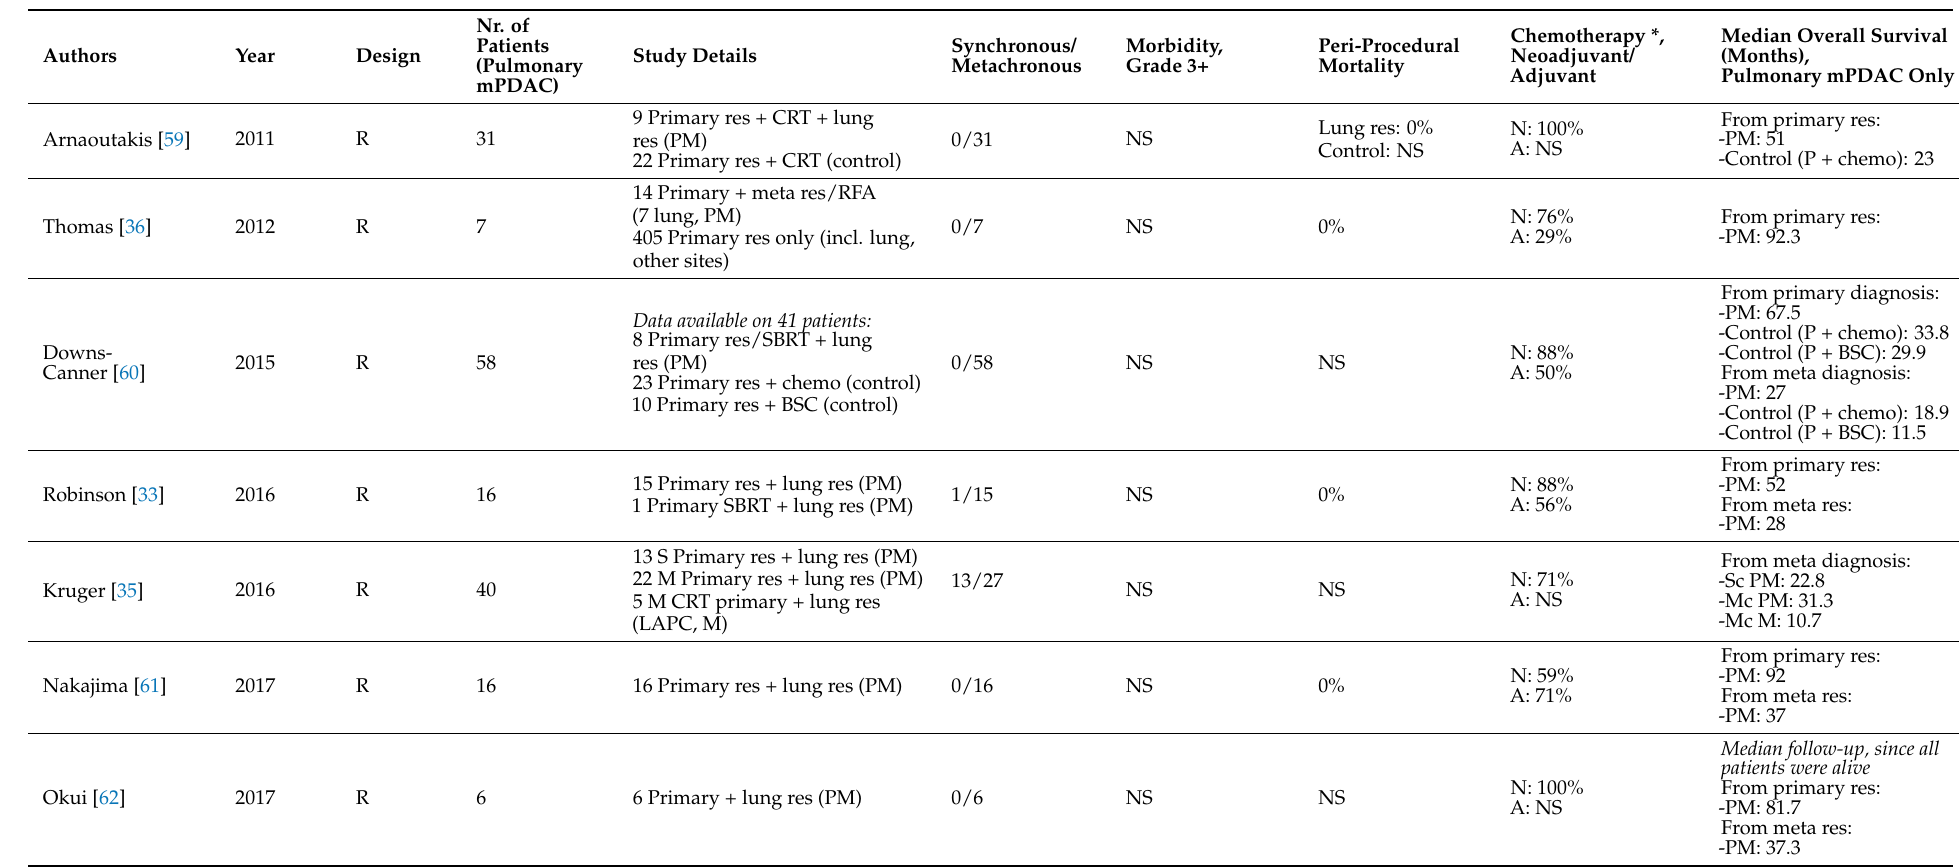
Table 4. Pulmonary metastasectomy in mPDAC. NS = not specified; R = retrospective; PM = primary + metastatic resection; P = primary resection; M = metastatic resection; res = resection; CRT = chemoradiotherapy; chemo = chemotherapy; BSC = best supportive care; RFA = radiofrequency ablation; SBRT = stereotactic body radiotherapy; meta = metastasis; R0,1,2 = resection margin; LAPC = locally advanced pancreatic cancer; Sc = synchronous; Mc = metachronous; N = neoadjuvant chemotherapy; A = adjuvant chemotherapy. * From the pulmonary resection point of view. Neoadjuvant: after pancreatic resection or prior to pulmonary metastasectomy. Adjuvant: after pulmonary